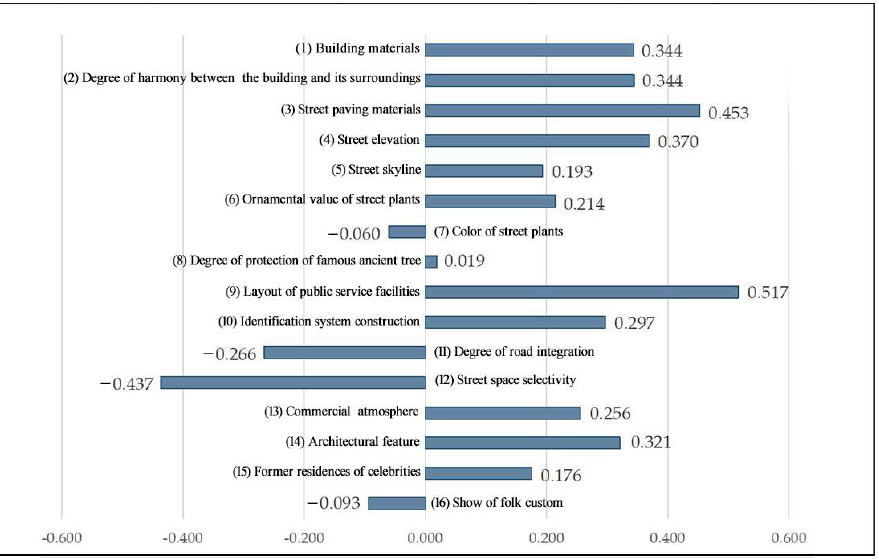
Figure 4. Evaluation values of landscape preference indicators for the “T - shaped” spatial sample .